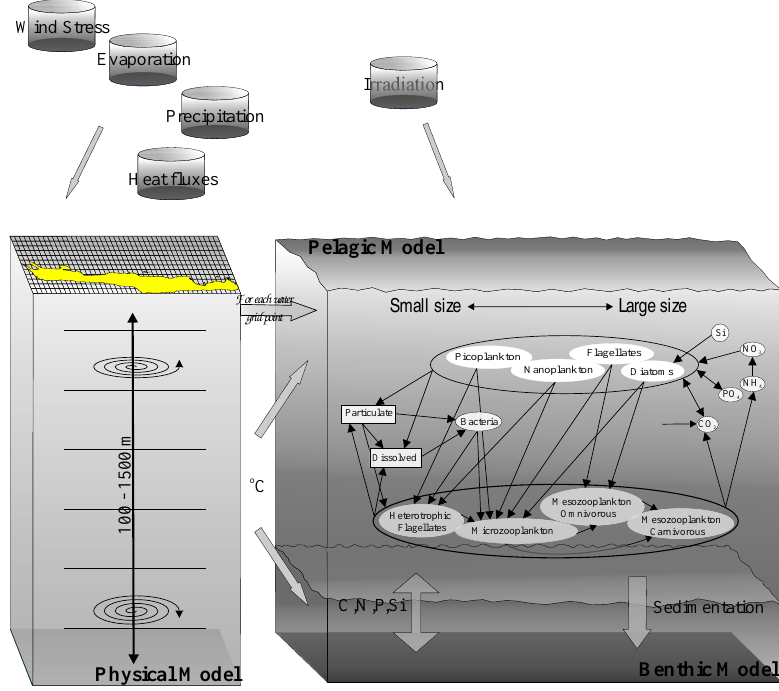
Fig. 1. Schematic representation of the ecosystem food